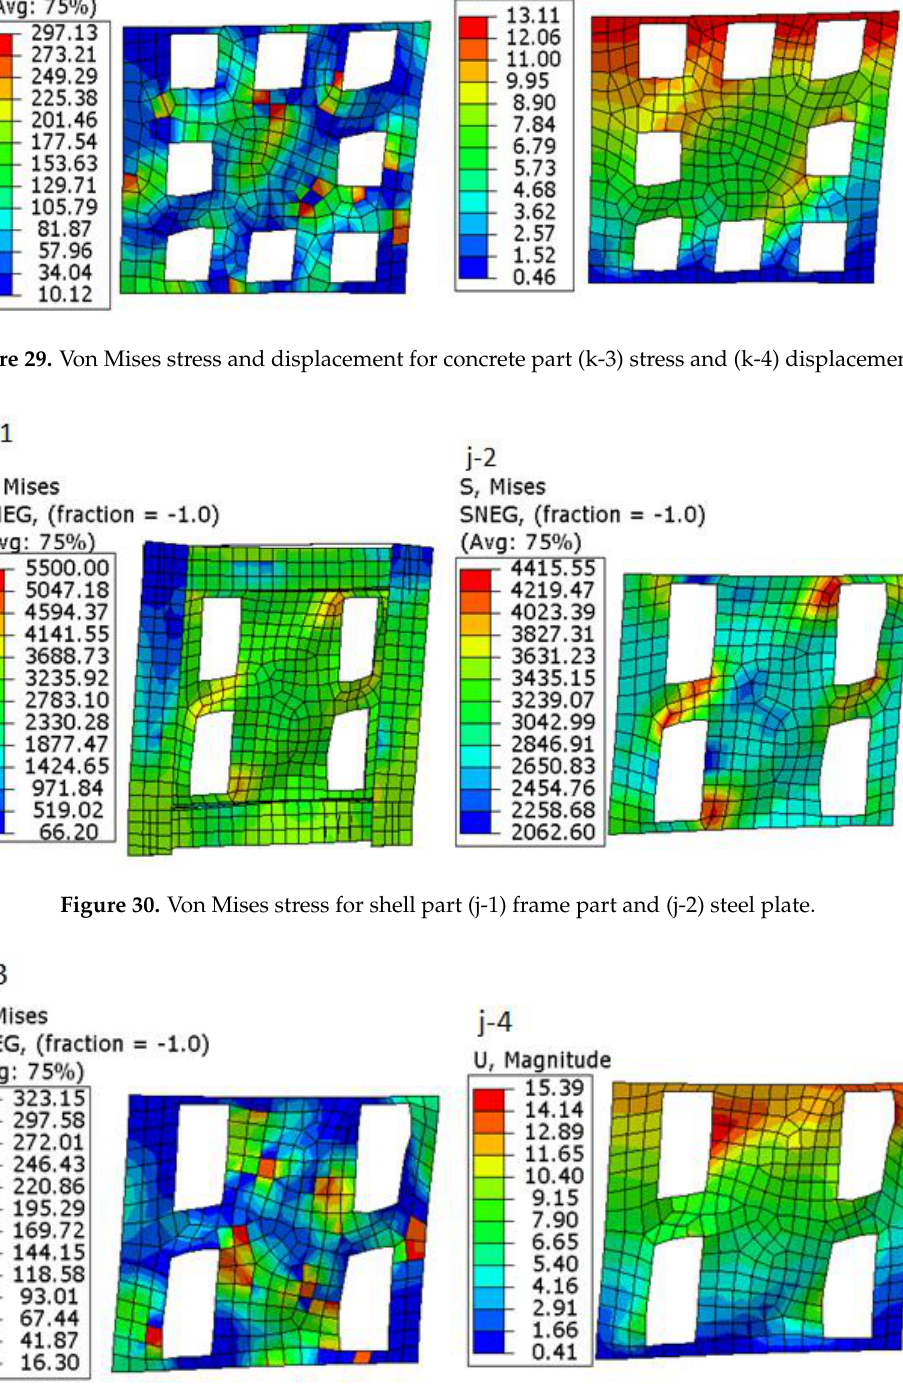
Figure 31. Von Mises stress and displacement for concrete part (j-3) stress and (j-4) displacement.